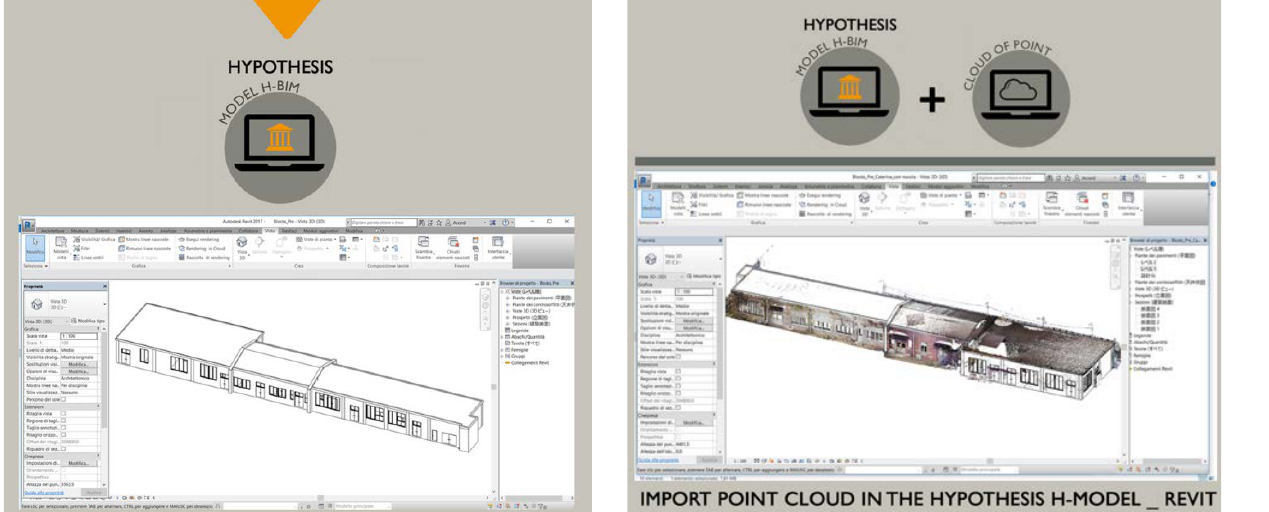
Figure 13: Overlapping hypothesized model and cloud of